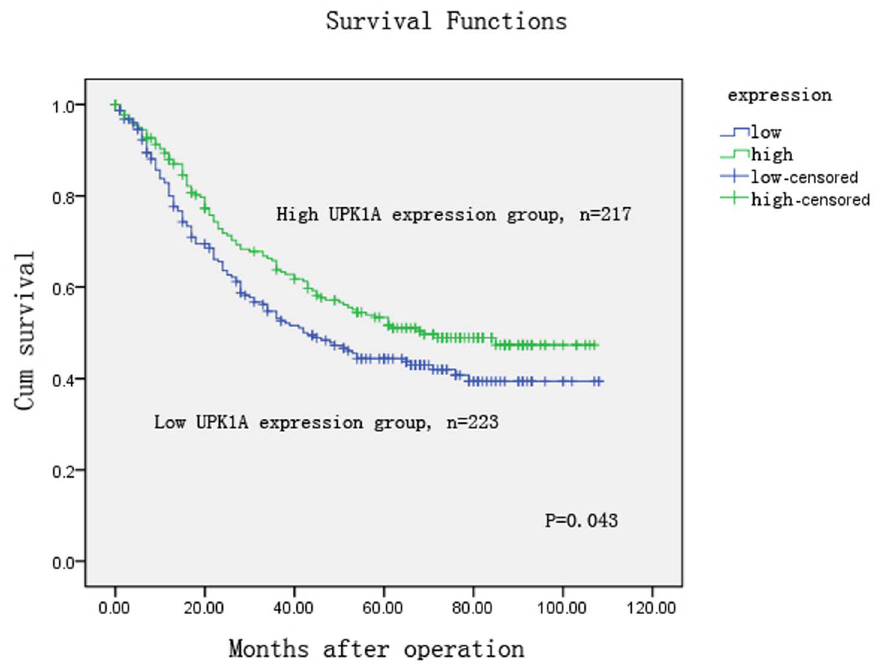
Figure 4. Kaplan-Meier survival analysis of gastric cancer patients (n=445). The survival rate of patients in the UPK1A-high group was higher than that of the patients in the UPK1A-low group (log-rank test, P=0.043).